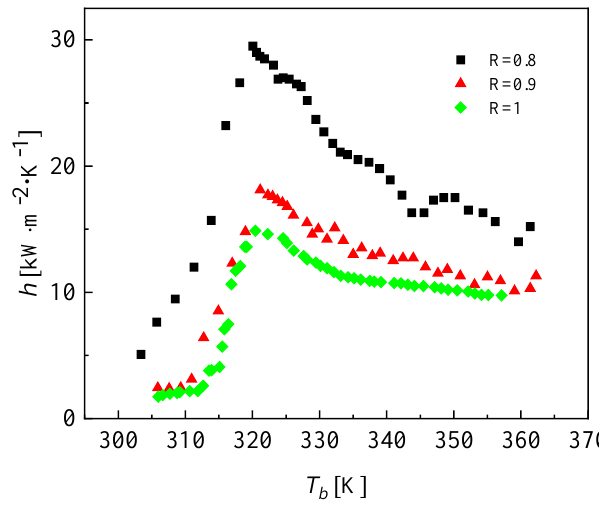
Figure 19. Effect of channel radius on the heat transfer coefficient of CO 2 .